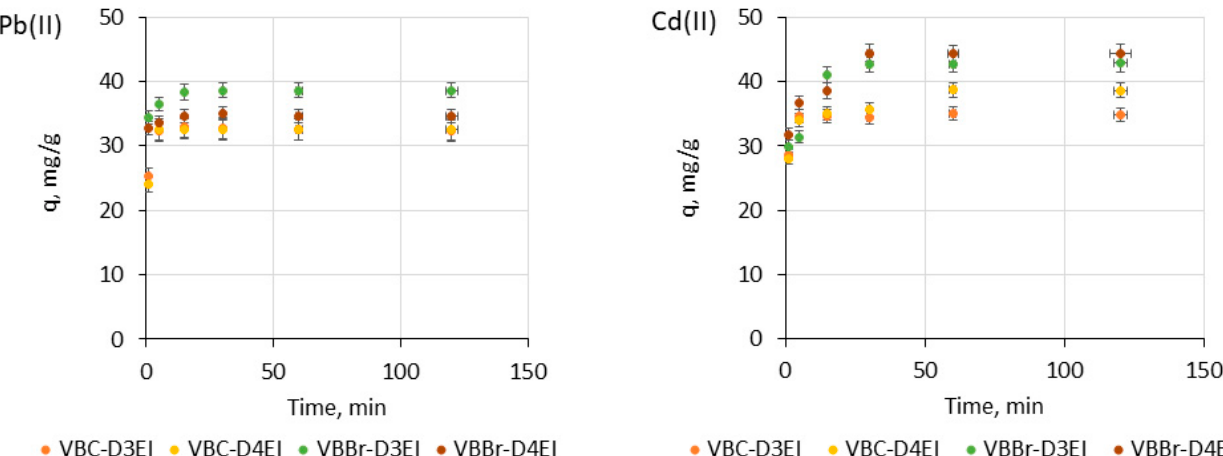
Figure 6. Effect of time on Pb(II) and Cd(II) adsorption onto the fabricated resins (metal ion concentration, 50 mg/L; sorbent dosage, 0.1 g; V, 100 mL).